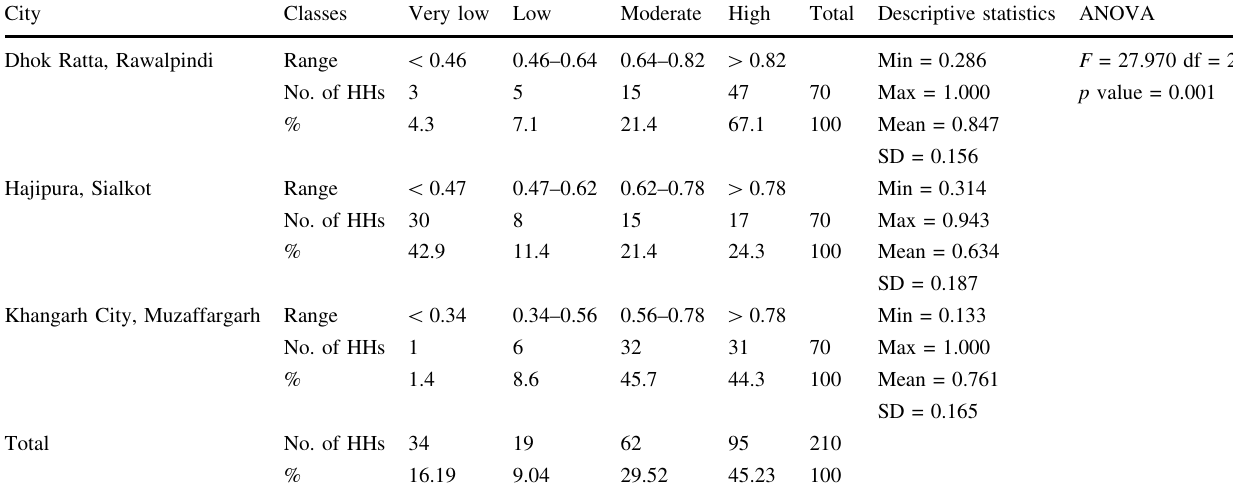
Table 5 Institutional vulnerability to urban flooding in Dhok Ratta, Hajipura, and Khangarh City, Punjab Province, Pakistan (HHs = House- holds; n = 210) City